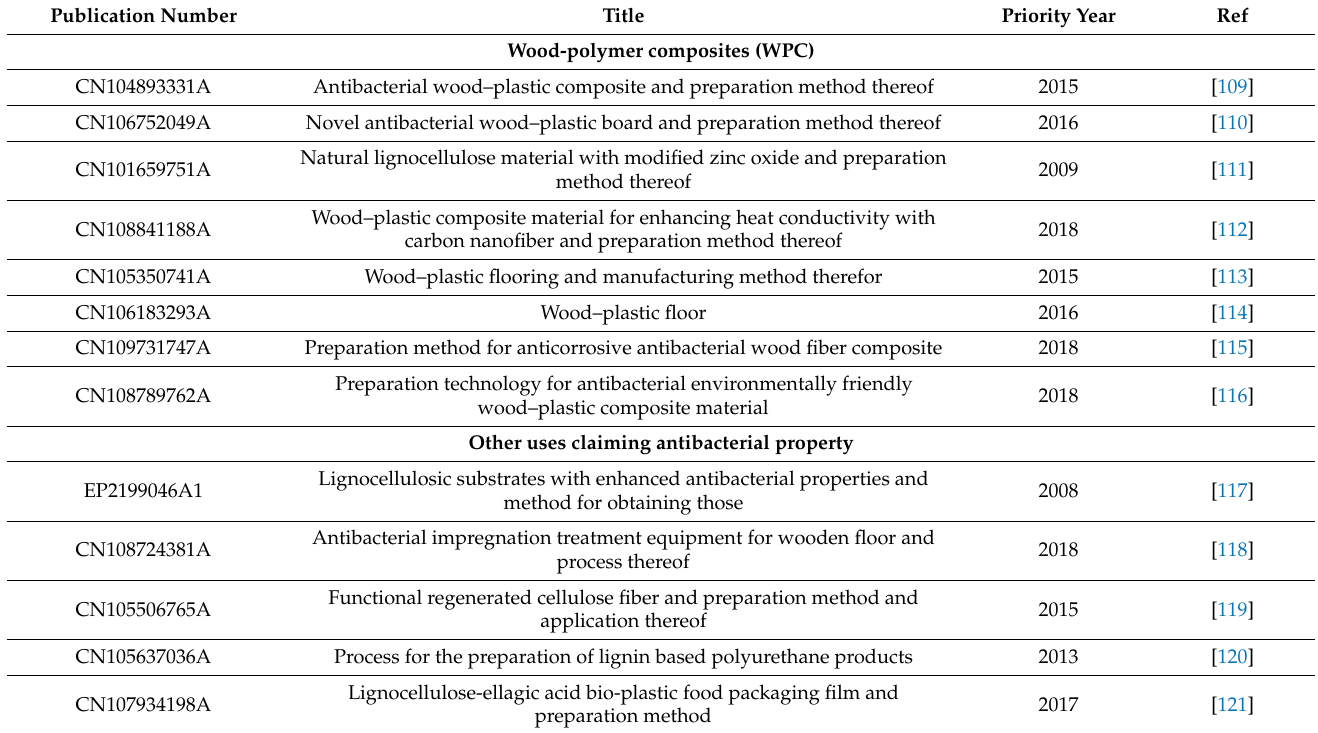
Table 3. Results of patent search on antimicrobial lignocellulosic-related